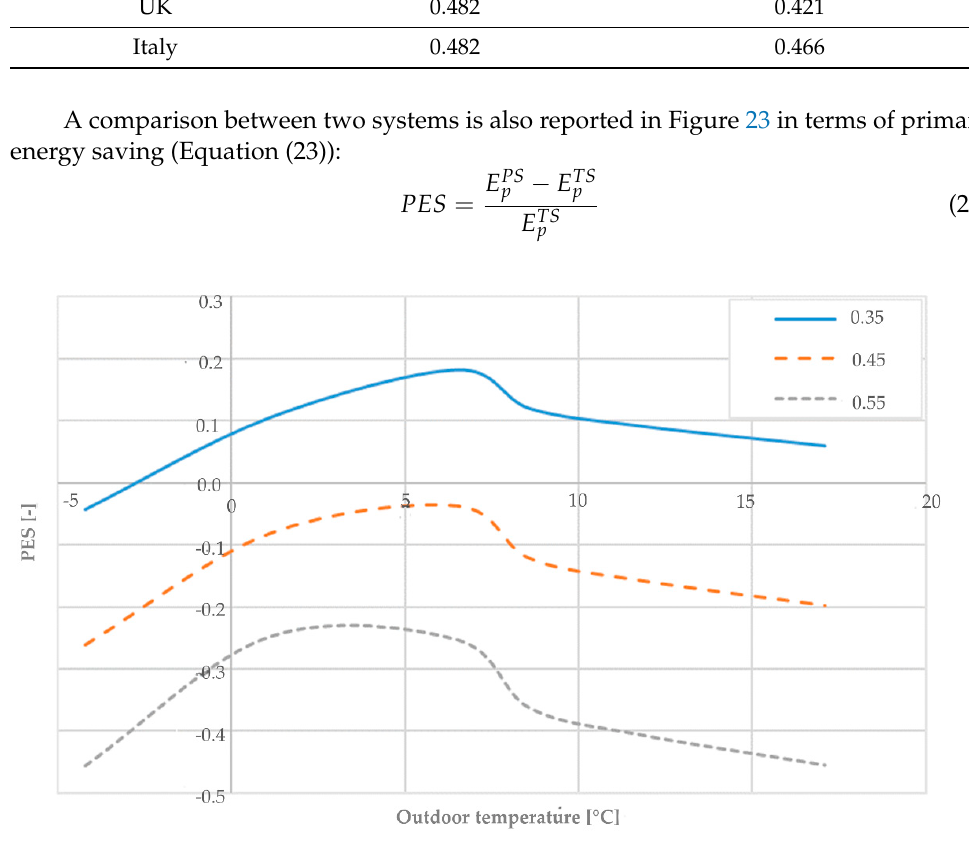
Figure 24. Δ CO 2 as a function of outdoor air temperature and CO 2 emission factor. 1.3.4. Comparison GEHP/EHP: Cooling Mode In this section, a comparison between GEHP with and without the DHW kit and EHP working in cooling mode combined or not with a boiler on an energy and environmental basis is reported. The comparison is performed considering that both the systems deliver the same amount of cooling and thermal energy. In Figure 25, GEHP and EHP/B systems are shown. The reference electric efficiency is considered equal to 0.437 according to the EU28 power grid average value [45], while for the natural gas-fuelled boiler, thermal effi- ciency is 0.926. The emission factors considered for environmental analysis are 0.634 kg CO 2 /kW h el [45] for electricity (EU28, Table 1) and 0.205 kg CO 2 /kW h Ep for natural gas. The information used for the PER evaluation is taken from [43] for GEHP and from [44] for EHP.